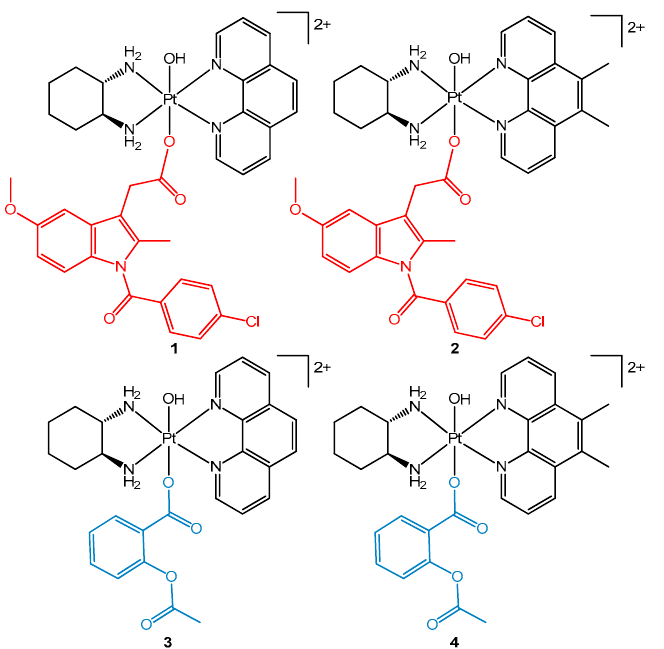
Figure 2. The chemical structures of multi-functional platinum(IV) prodrugs comprising of the COX inhibitors indomethacin ( 1 and 2 ) and aspirin ( 3 and 4 ) in the axial positions.